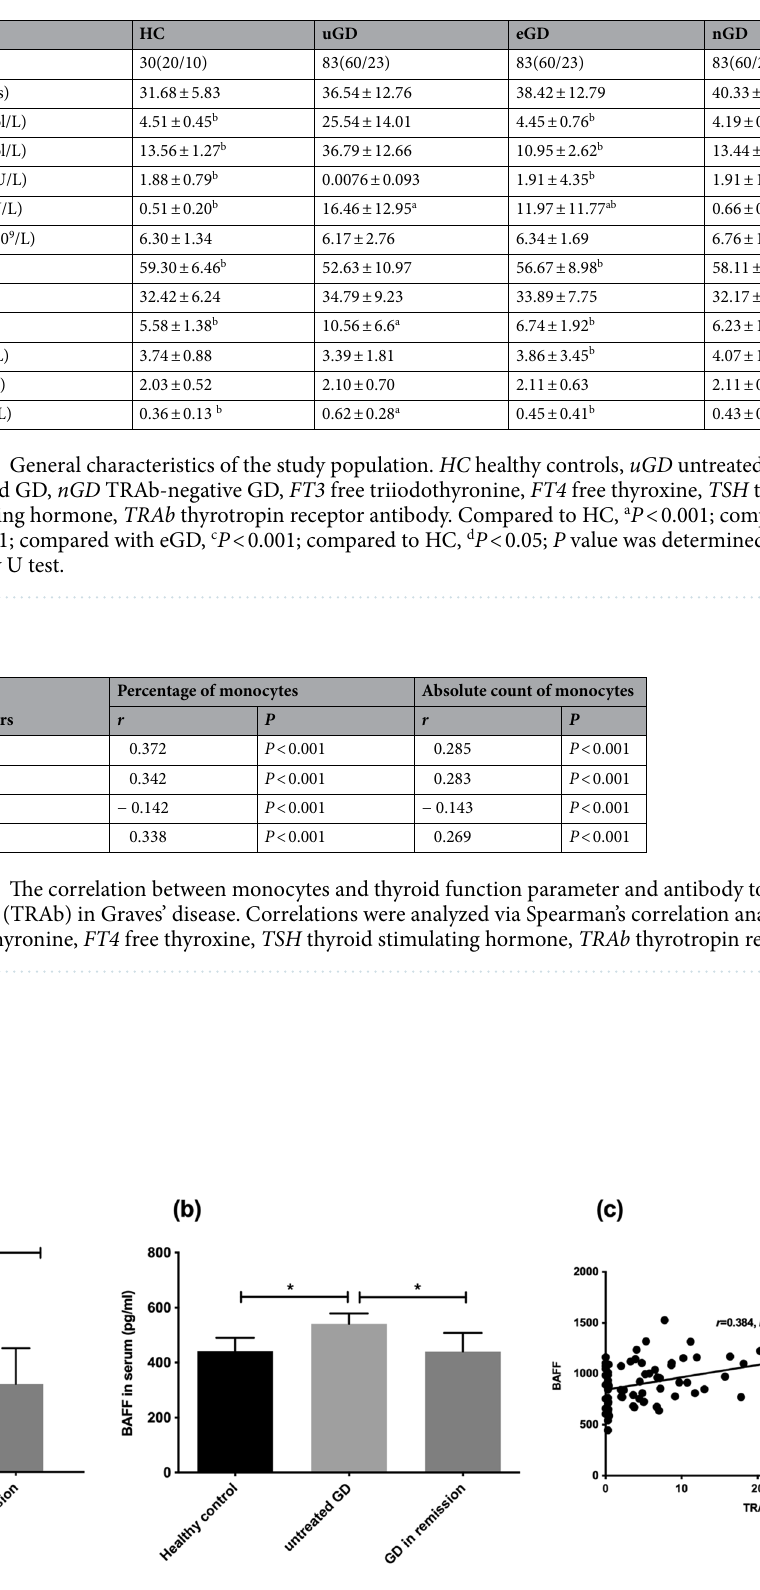
Figure 1. B cell activating factor (BAFF) expression in monocytes and serum and its correlation with TRAb. (a) , BAFF mRNA expression in the monocytes of healthy controls (n = 10), patients with untreated GD (n = 24) and patients with negative TRAb GD in remission (n = 6) using real-time PCR; (b) , ELISA assay for BAFF expression in the serum of healthy controls (n = 14), patients with untreated GD (n = 56) and GD patients in remission (n = 12); (c) , correlation analysis of TRAb and serum BAFF levels in patients with untreated GD; ** P <